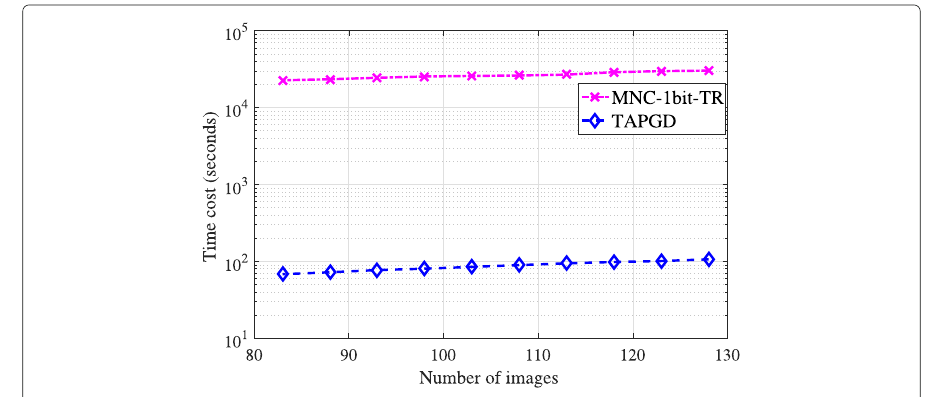
Fig. 7 Time cost of TAPGD and